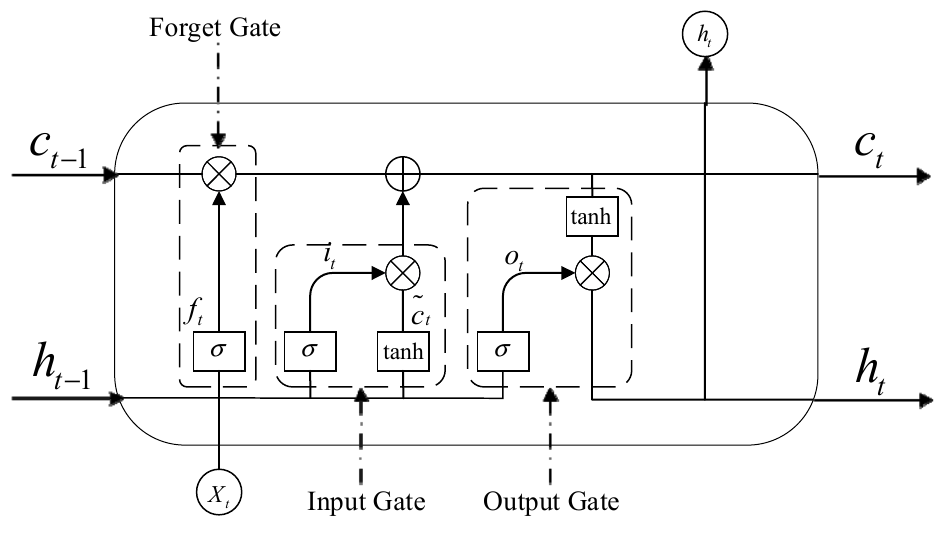
Figure 2. Standard LSTM structure